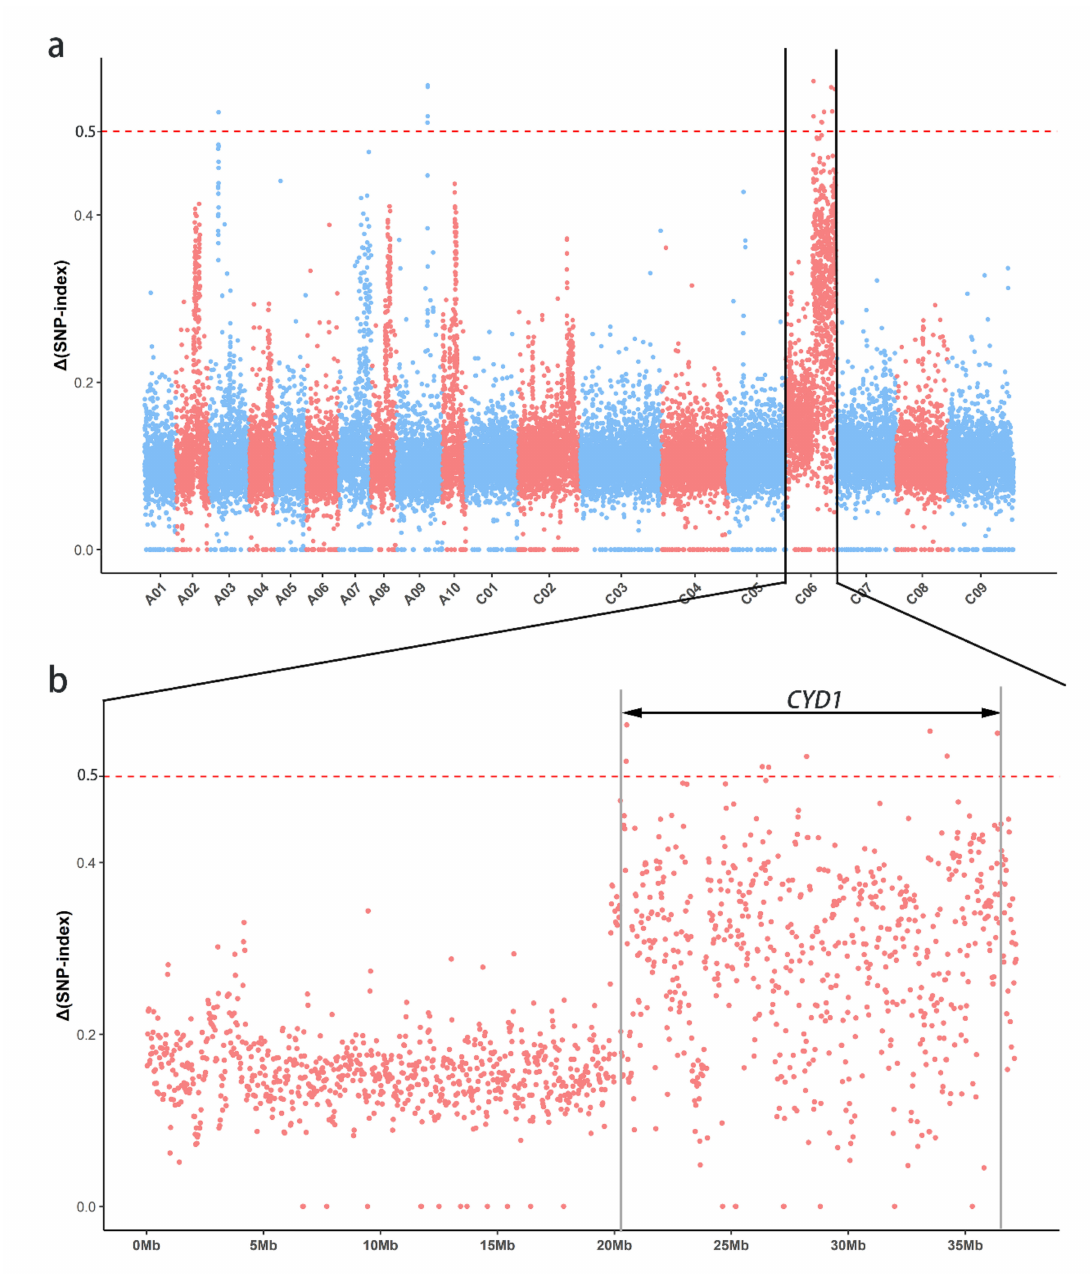
Figure 2. Candidate regions of CYD1 identified by whole-genome resequencing. ( a ) The x-axis represents the 19 chro- mosomes of Brassica napus arranged by physical position. The y-axis represents the value of ∆ (SNP index), which was calculated by subtracting the SNP index of 7-521Y from that of 7-521G. ( b ) Enlarged view of chromosome C06. The candidate gene interval (marked by arrow) was determined using 0.5 as the threshold, and chromosome A03 and chromosome A09 were excluded through marker